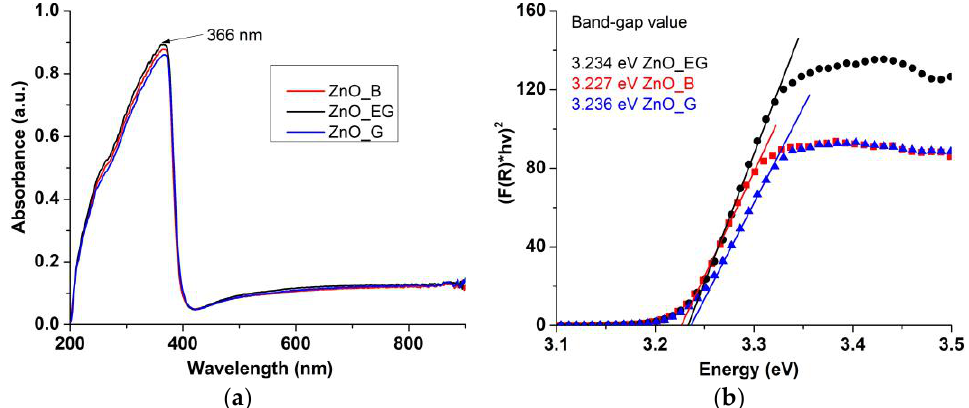
Figure 7. The UV-Vis spectra for ZnO_B, ZnO_EG and ZnO_G samples ( a ); the band-gap energy values ( b ).